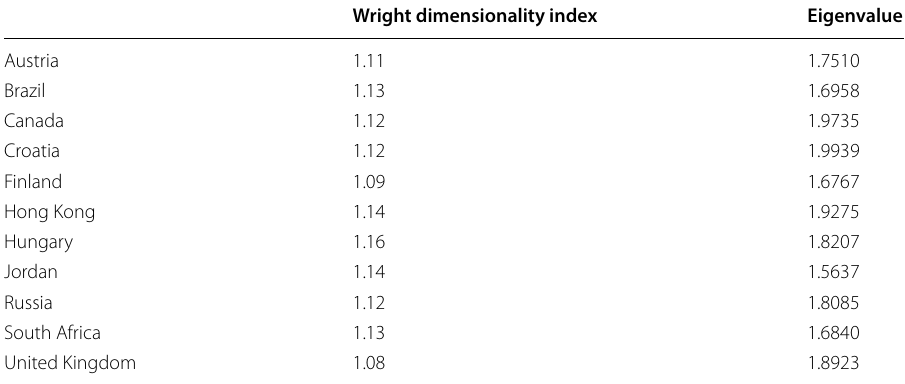
Table 2 Results of Unidimensionality. Source: summarised from WINSTEPS ® output (Linacre